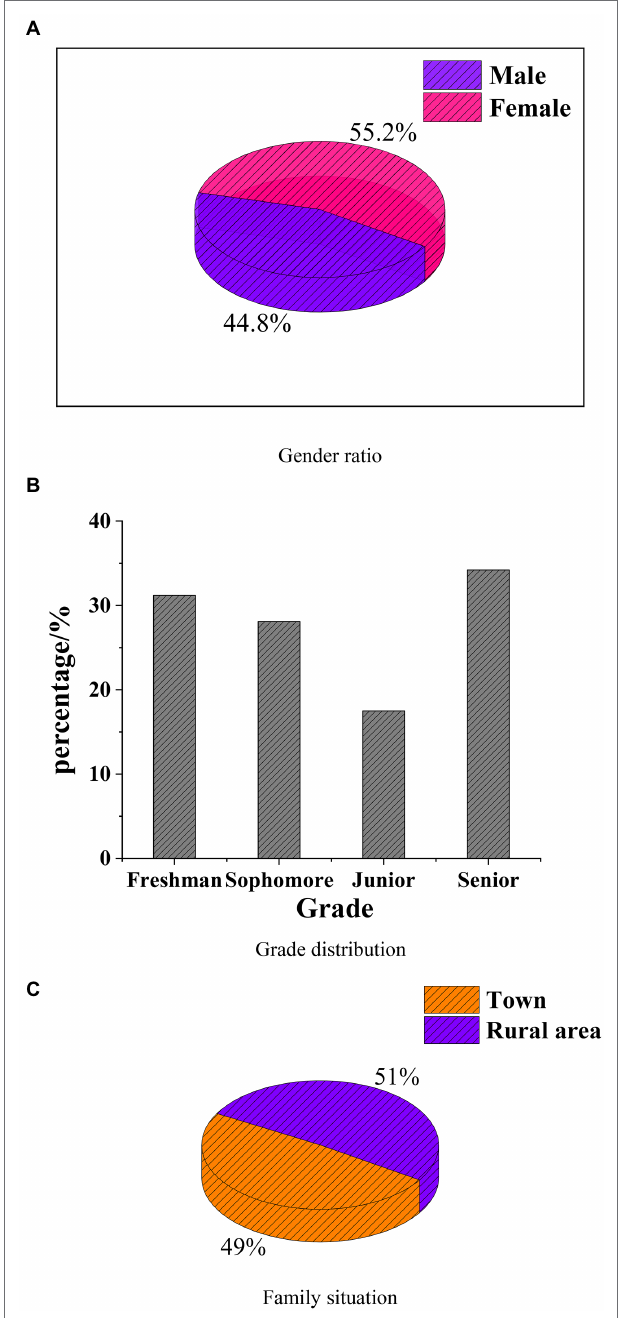
FIGURE 5 | Basic information of the research object. (A) Gender ratio. (B) Grade distribution. (C) Family situation.